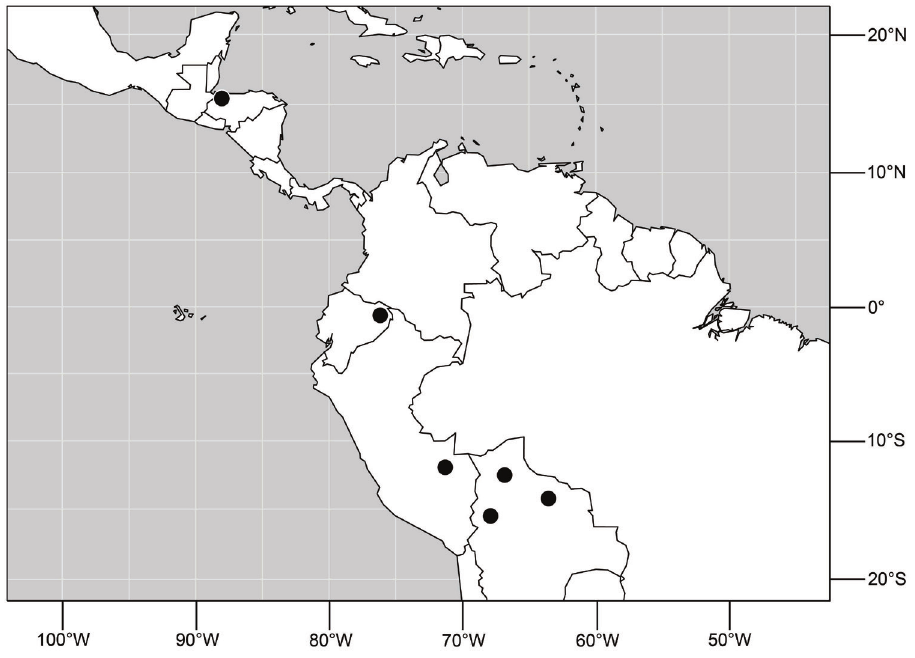
Figure 69. Distribution of Hydrochasma denticum sp.